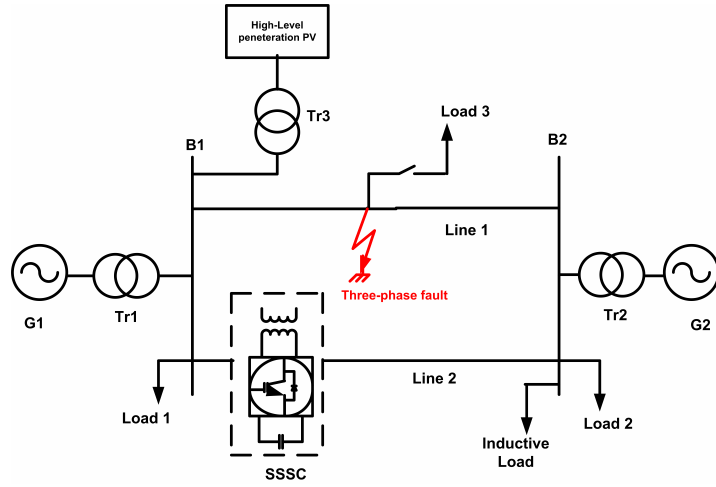
Figure 1. Investigated hybrid microgrid System.